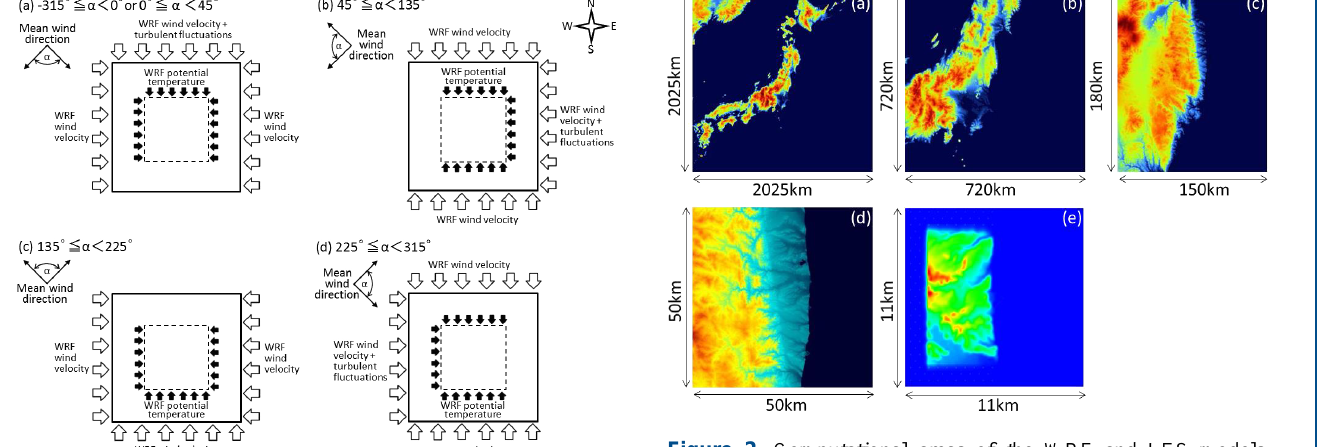
Figure 2. Computational areas of the WRF and LES models. The WRF is configured with for nested domains covering areas of (a) 2025km × 2025km at 4.5km grid, (b) 720km × 720km at 1.5km grid, (c) 150km × 180km at 500m grid, and (d) 50km × 50km at 100m grid. The LES model covers an area of (e) 11km × 11km at 20m